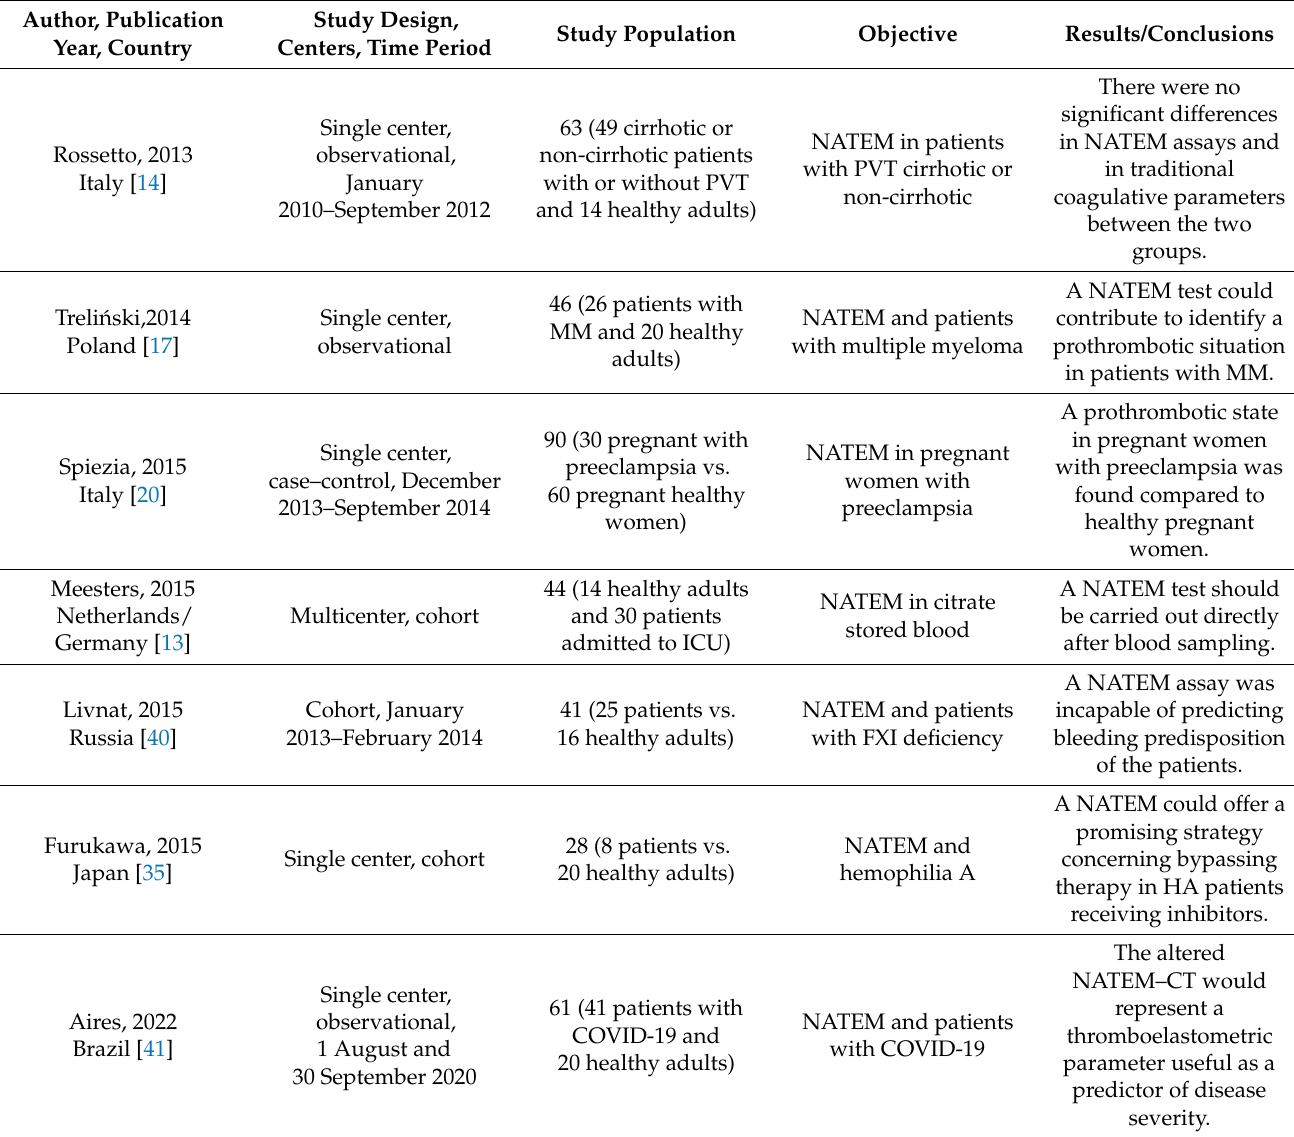
Table 3. Comparison of NATEM parameters between healthy adult volunteers and